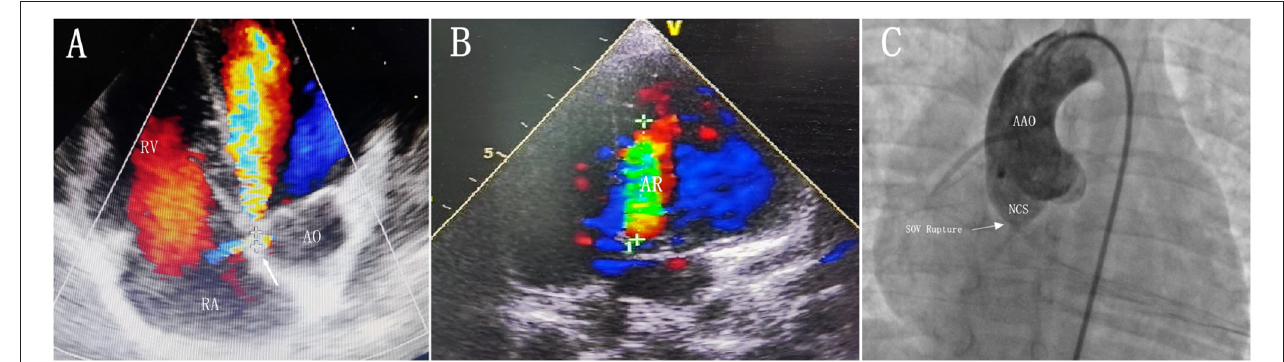
FIGURE 1 | (A) Transthoracic echocardiogram obtained in the five-chamber view showing that the SOV rupture occurr in the non-coronary sinus and rupture into the right atrium. (B) Transthoracic echocardiogram obtained in the apical long axis view showing a mild-to-moderate aortic regurgitation. (C) Aortography showing significant shunting between NCS and the right atrium. The defect diameter of 3mm was measured by aortography. AR, aortic regurgitation; AO, aorta; AAO, ascending aorta; RA, right atrium; RV, right ventricle; NCS, non-coronary sinus of Valsalva; SOV rupture, Sinus of Valsalva rupture.